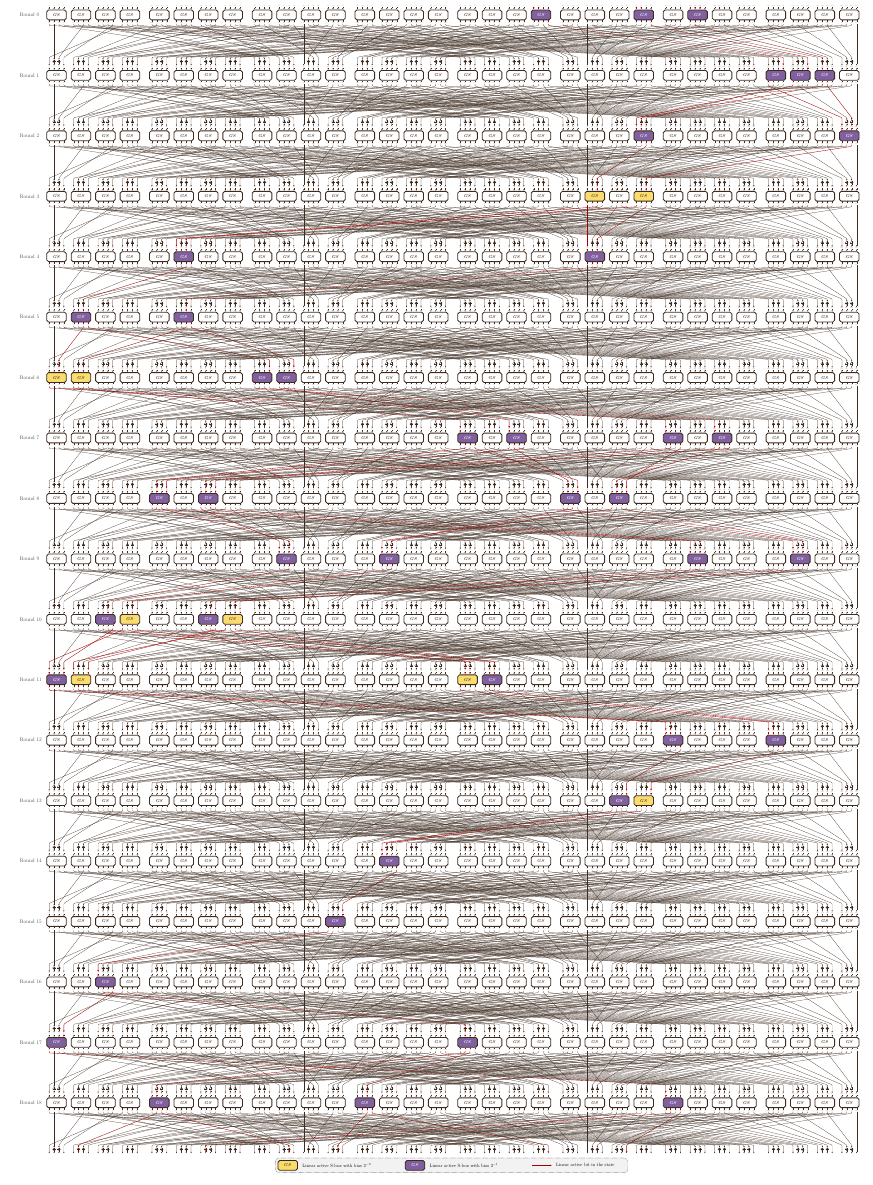
Figure 11: 19-round trail with c = 2 − 59